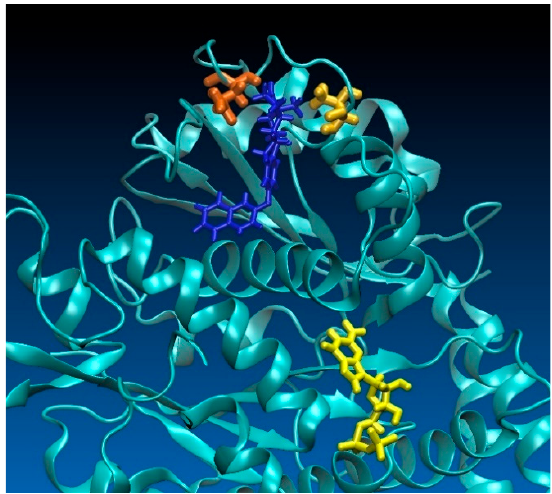
Figure 6. Relative position of compound 14i (blue), Gln-282 (dark orange), Thr-276 (light orange) and GDP (yellow) nearby the taxoid binding site in the tubulin protein.